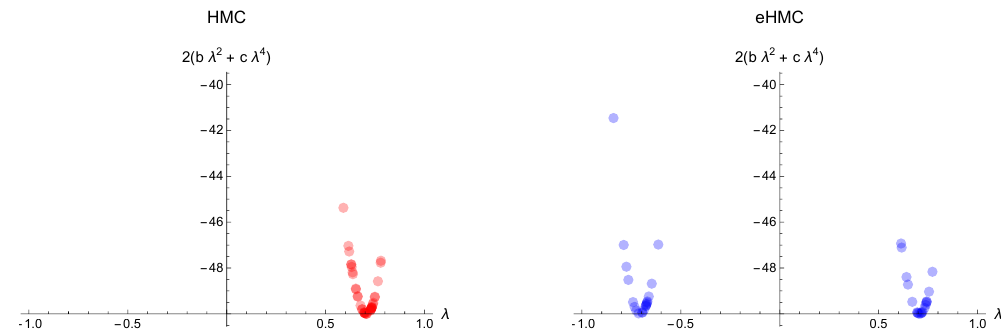
Figure 1 . Eigenvalues of the first 40 configurations for the system with the action (2.1) with N = 2 , b = − 100 and c = 100 . On the vertical axis we show the action corresponding to each eigenvalue. We can see that the eHMC algorithm very quickly probes both potential wells and finds the symmetric solution, despite being initiated in the false (asymmetric) vacuum in which the HMC algorithm becomes stuck.